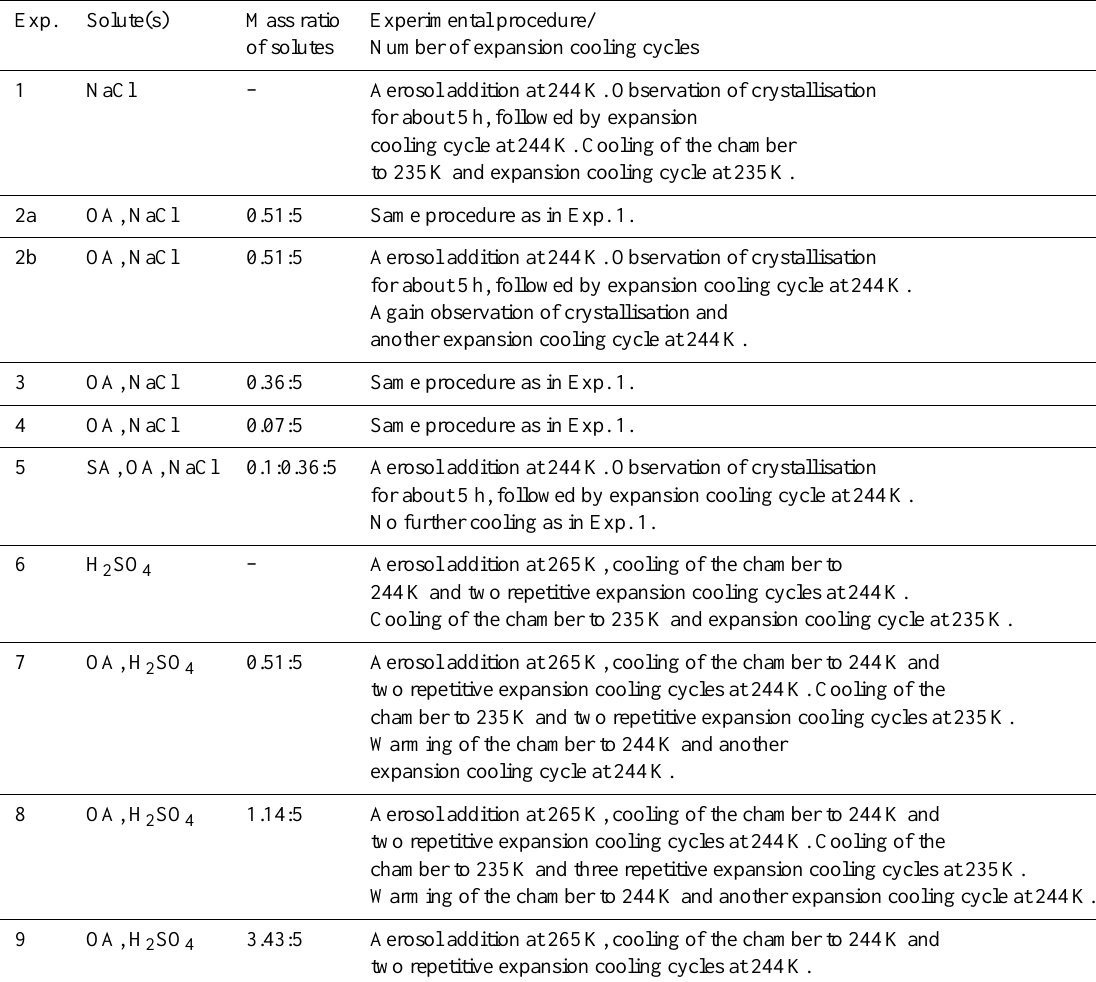
Table 1. Compilation of the various ice nucleation experiments in the five investigated systems NaCl/H 2 O, NaCl/OA/H 2 O, NaCl/OA/SA/H 2 O, H 2 SO 4 /H 2 O, and H 2 SO 4 /OA/H 2 O. The procedure for each experiment is discussed in detail in Sect.